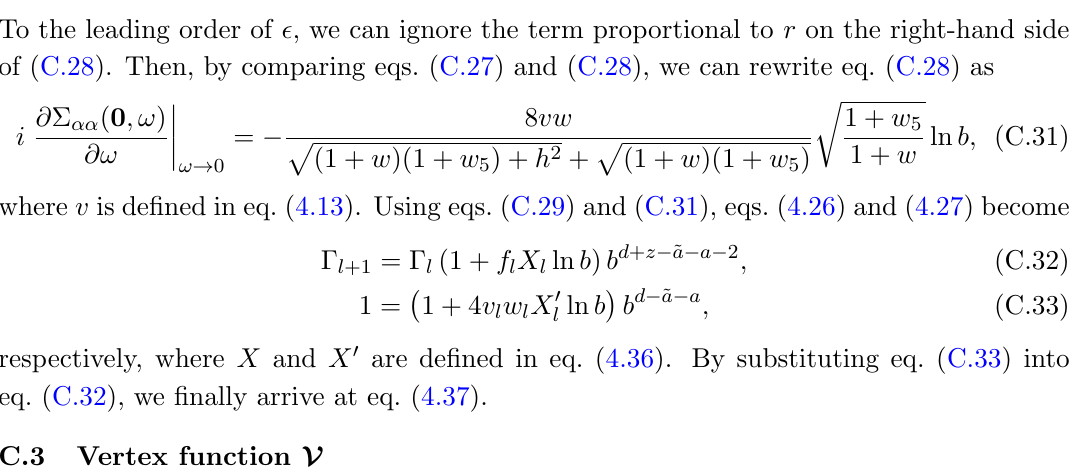
(cid:11) ; (cid:12)i at one-loop